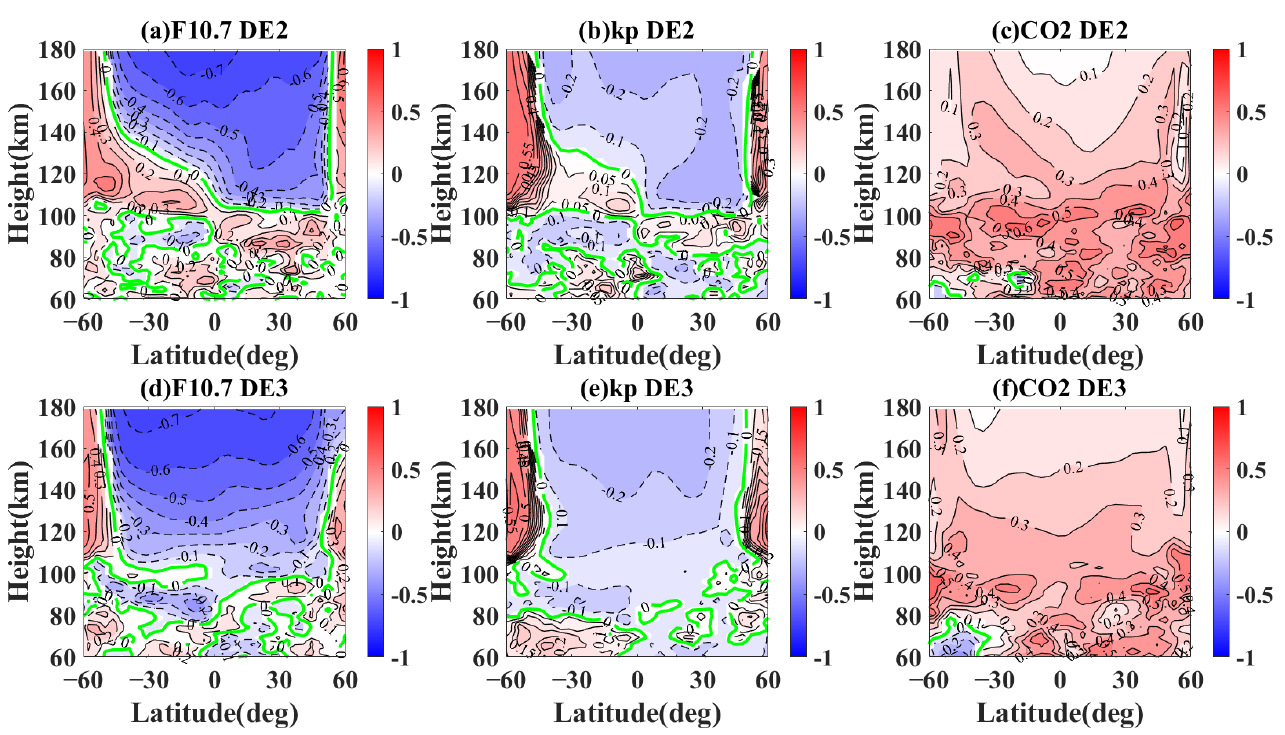
Figure 8. The correlation between non-migrating tidal variations ( a – c ) DE2, ( d – f ) DE3, and ( a , d ) F10.7 cm index, ( b , e ) kp index, and ( c , f ) CO 2 between 60 ° S and 60 ° N from 2003 to 2019. The green curve means the zero lines.